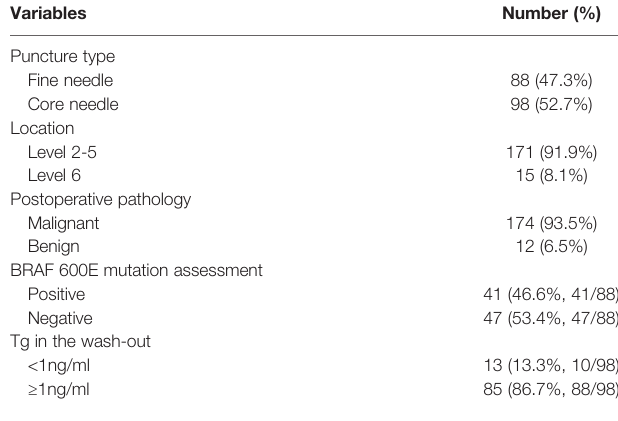
TABLE 2 | Information of the 186 punctured lymph